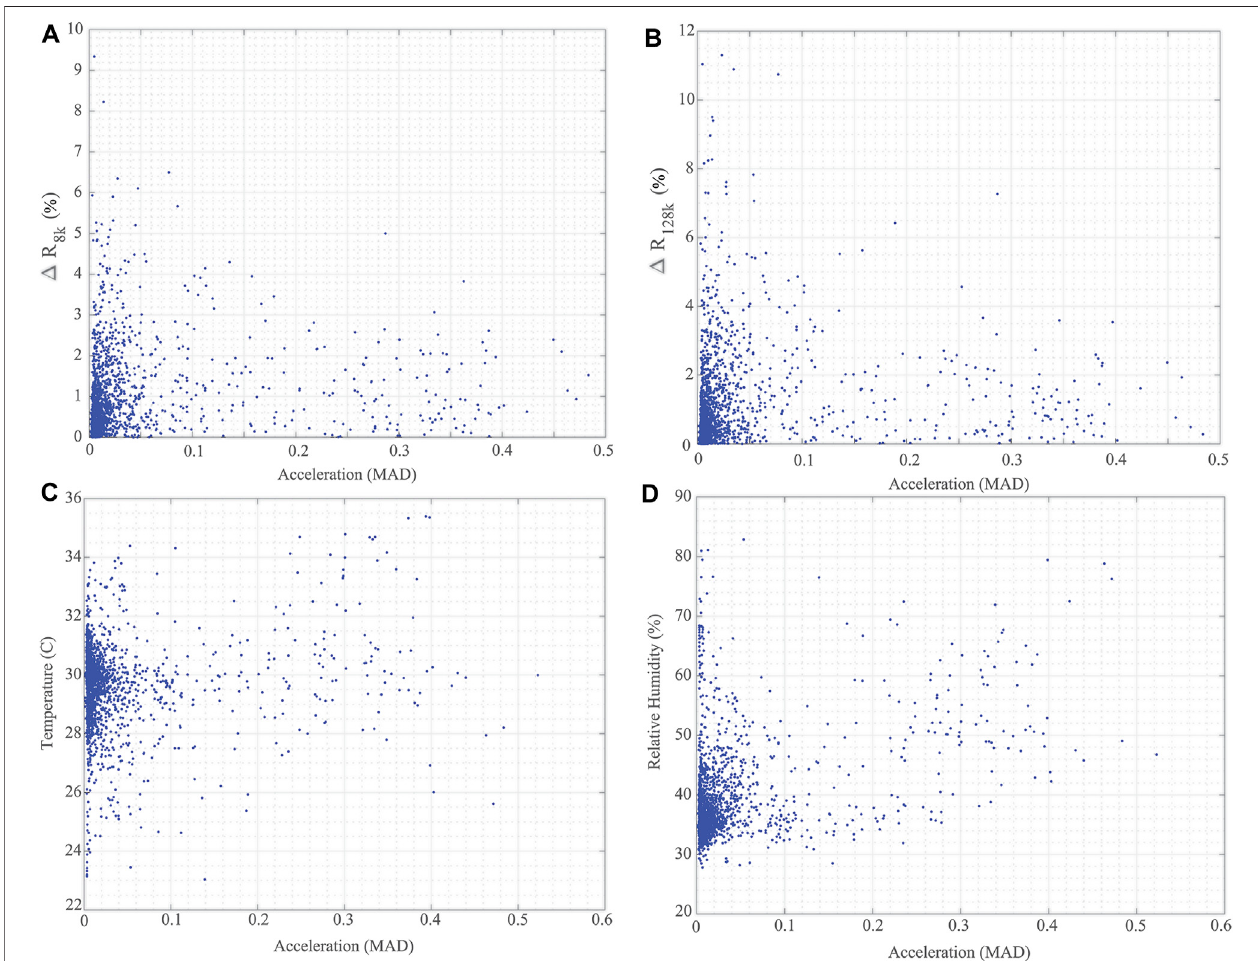
FIGURE 11 | Comparisons of (A) Δ R 8 k , (B) Δ R 128 k for longitudinal knee bioimpedance, (C) temperature, and (D) humidity reported by wearable with acceleration MAD from participants across 2-day data collection.